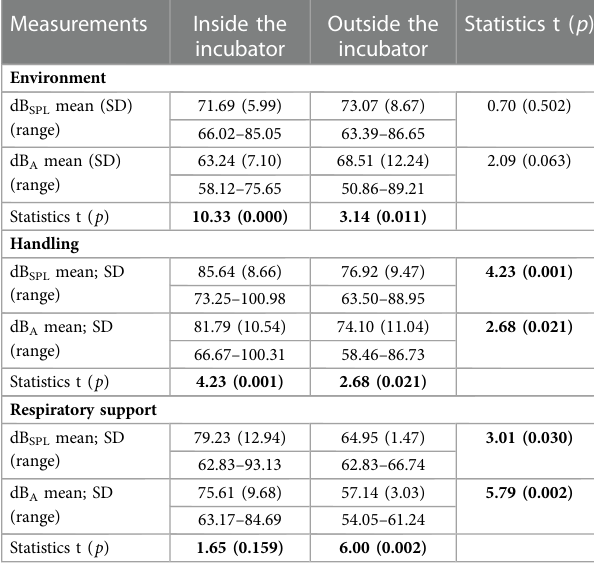
TABLE 3 t -test comparing ranked NICUs noises.